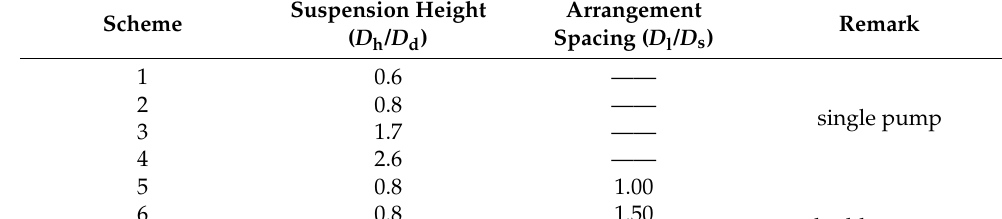
Figure 5. Grid independence. Table 1. The number of grids and nodes in each computing part.